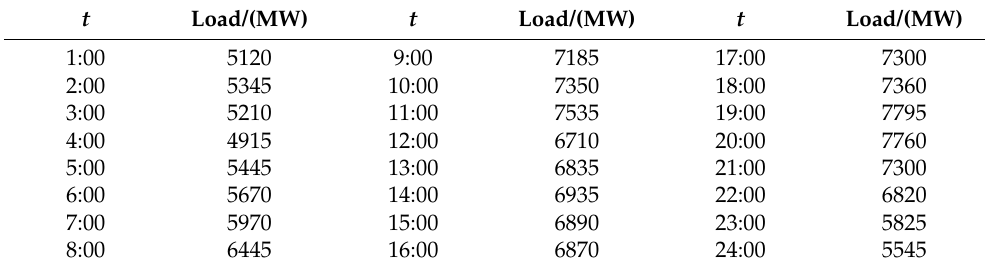
Table 1. Load data of a typical Day.